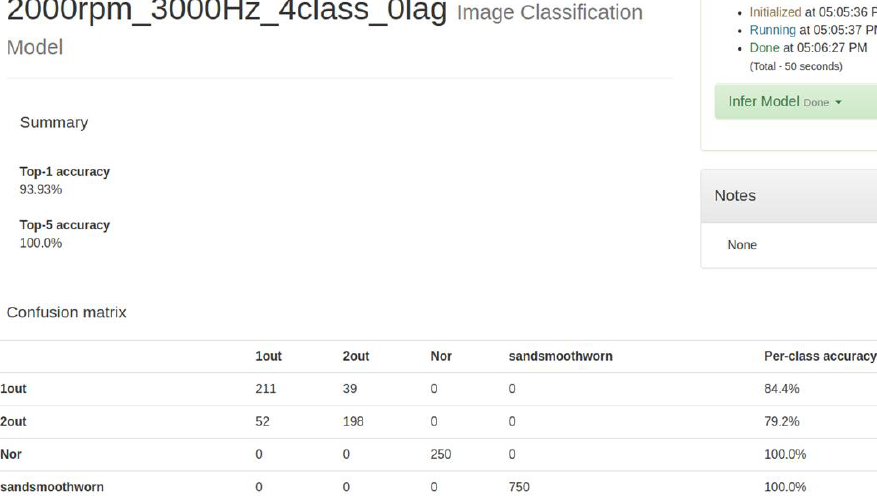
Figure 19. Confusion matrix for the improved formula of symmetrized dot pattern (SDP) as 1 t  (sampling at 3000 Hz/2000 rpm). 3.3. Comparison of CNN and SVM After the optimum conditions for CNN were found, a comparison was made with those from SVM. The first conclusion reached from the six diverse classifications involved rotational speed. The experimental configuration table and results of SVM and CNN included a sampling frequency at 3000 Hz on the D4 band. The features were mean, standard deviation, and median absolute deviation. The teaching data were 500 data items from the first half of all data. The testing data were 500 data items from the second half of all data. The accuracy of SVM under different rotational speeds is shown in Table 6. The identification rates by CNN were 73.53% at 1000 rpm, 87.63% at 1500 rpm, and 94.20% at 2000 rpm. SVM was shown to be more accurate than CNN based on the experiments under the six conditions, for both rotational speed and malfunction simulation.